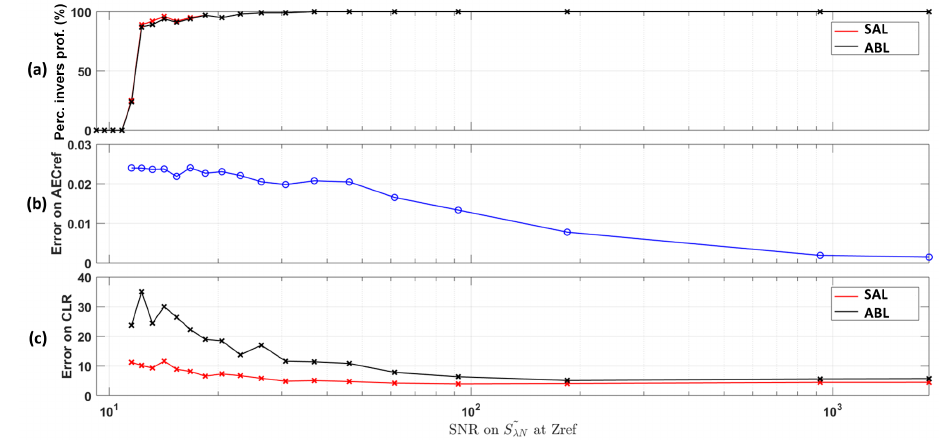
Figure 8. (a) Percentage of inversible profiles, (b) errors on AECref (AEC at the reference altitude, α aer (column-equivalent lidar ratio, in sr) due to random detection processes against the SNR at the reference altitude ( z ref ) on the Raman channel ( g S λN ) using the TDAM approach. Red and black lines show values for the SAL (smoke aerosol layer, between 1.1 and 1.8kma.m.s.l.) and for the ABL (atmospheric boundary layer, below 1kma.m.s.l.),